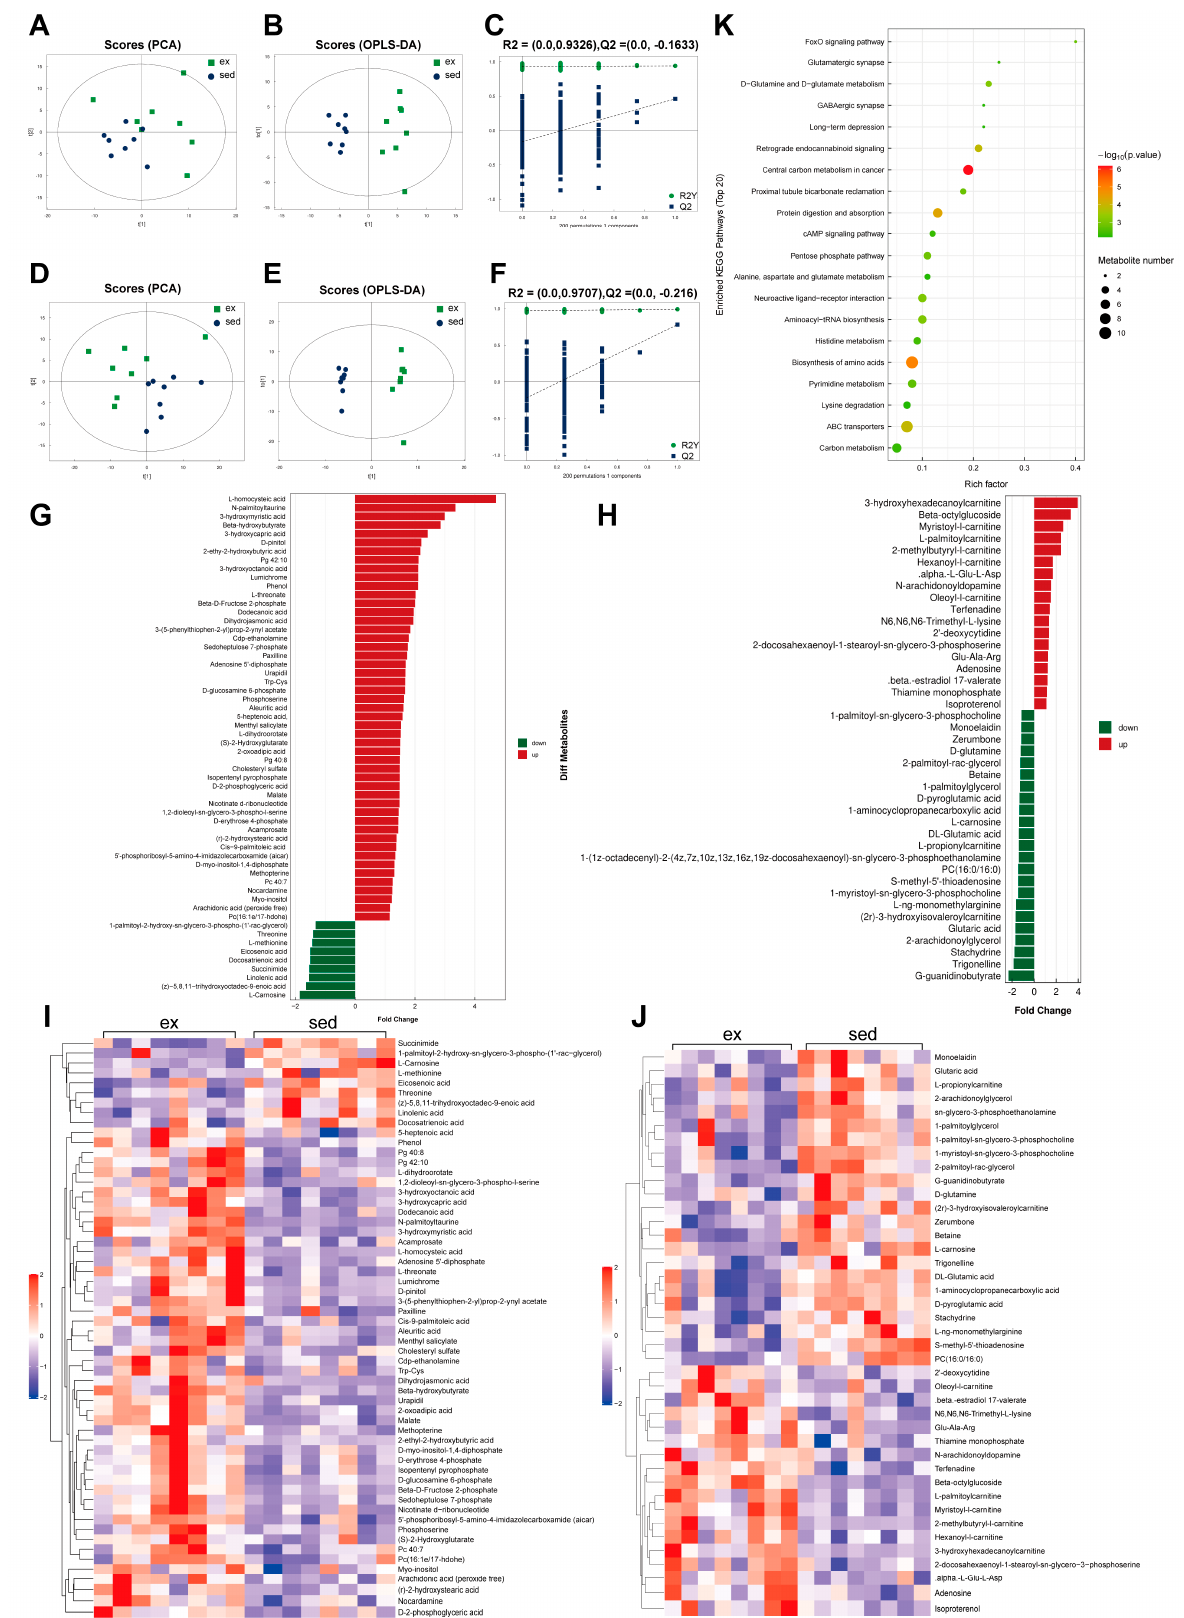
Figure 4. Effects of HIE on myocardial metabolism. ( A ) Positive-ion mode PCA score plot; ( B ) positive-ion mode OPLS-DA score plot; ( C ) positive-ion mode OPLS-DA 200-permutation test score